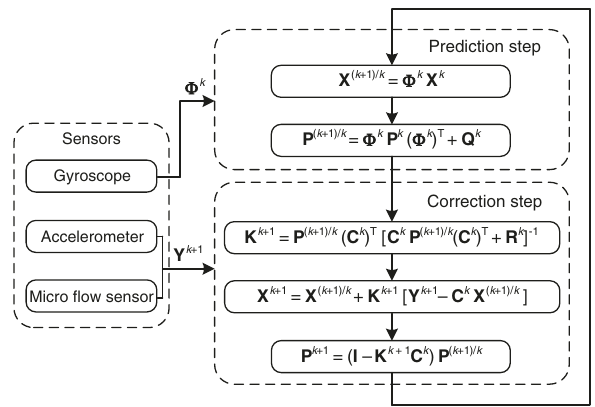
Fig. 3 The implementation process of the data fusion algorithm. P (k + 1 )/k is state vector prediction error, P k is the error of the fi lter output in the k th iteration, K k + 1 is the fi